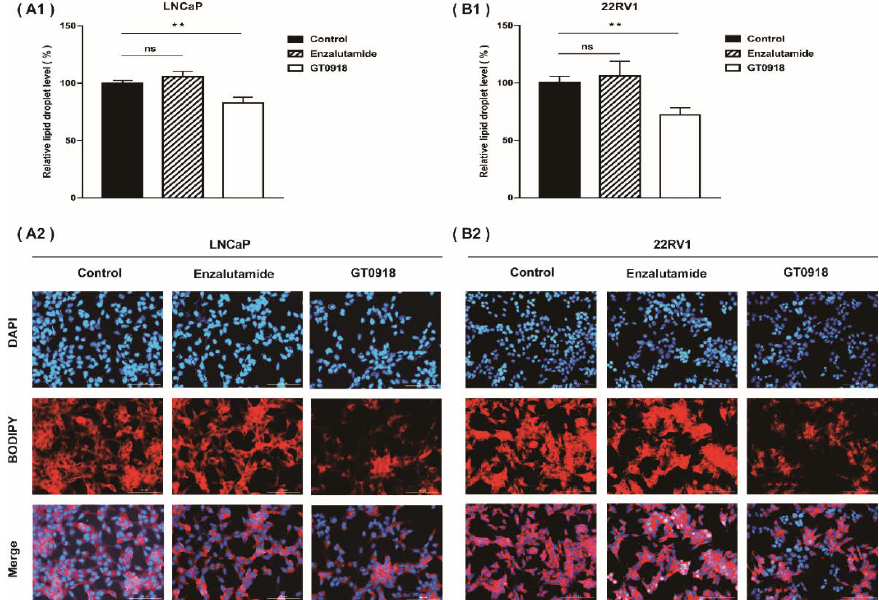
Figure 3. Proxalutamide (GT0918) reduced lipid droplet accumulation in LNCaP cells ( A ) and 22RV1 cells ( B ) examined by a BODIPY 558/568 C 12 staining assay. Data of relative lipid droplet level ( A1 , B1 ) are shown as the mean ± SD of three independent samples, ‘ns’ p > 0.05, ** p < 0.01. The typical images of lipid droplet accumulation in PCa cells after exposure to proxalutamide (20 μmol/L), enzalutamide (20 μmol/L) or control vehicle are shown on ( A2 , B2 ). Scale bars = 100 μm.